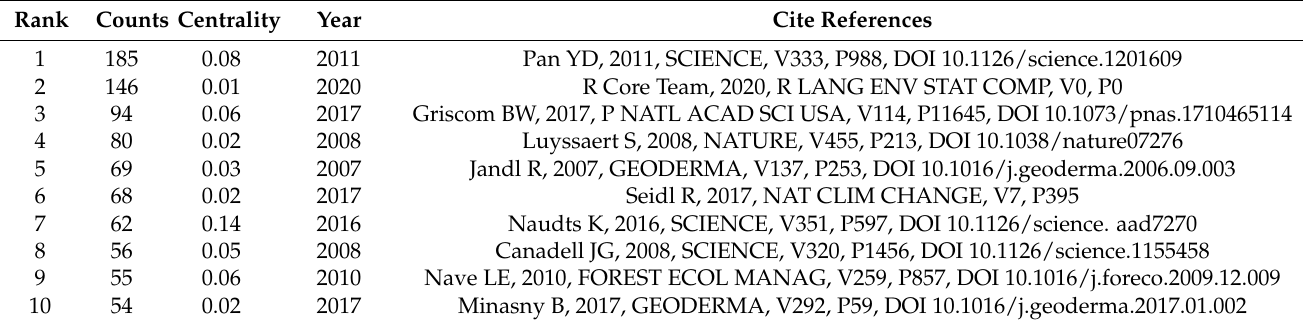
Table 8. The 10 most frequent papers in the literature co-citation analysis. (Rank 1) A Large and Persistent Carbon Sink in the World’s Forests. (Rank 2) R Core Team (2020). (Rank 3) Natural